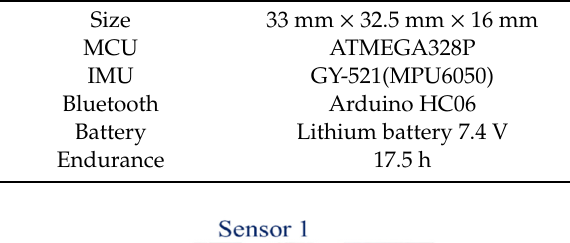
Figure 4. Two sensors worn on the thigh and ankle. Table 1. Specifications of the developed sensor device.